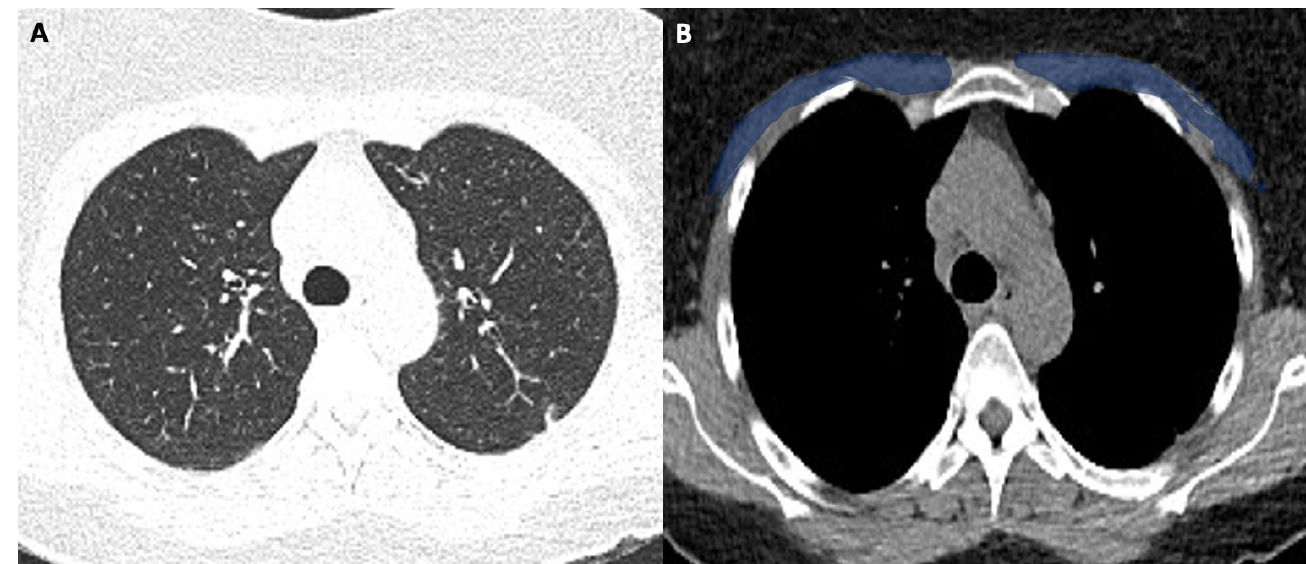
Figure 3 A - B . 63-year-old male with COVID-19. Figure 3. ( A , B ) 63-year-old male with